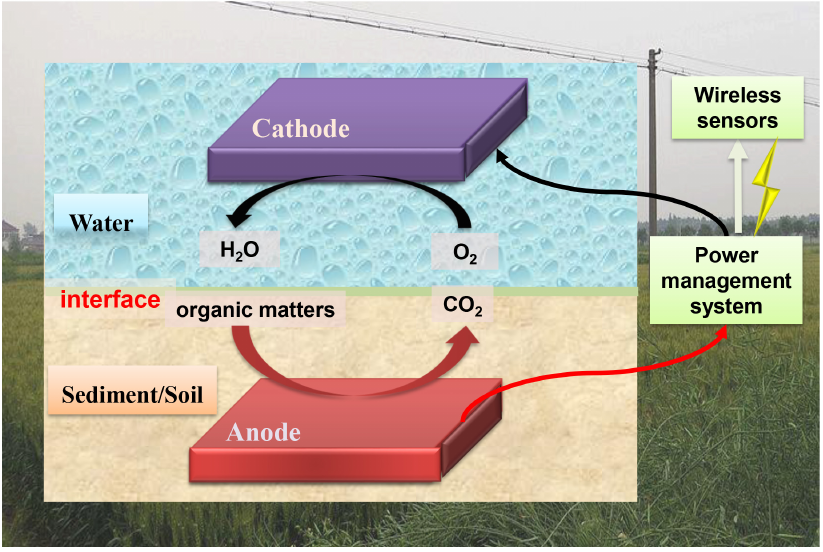
Figure 6. BES for powering wireless sensor for agricultural